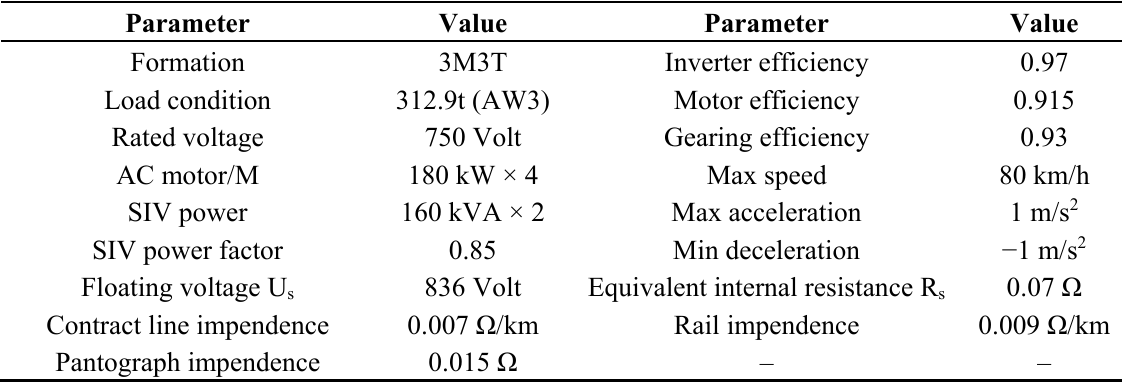
Table 2. Vehicle